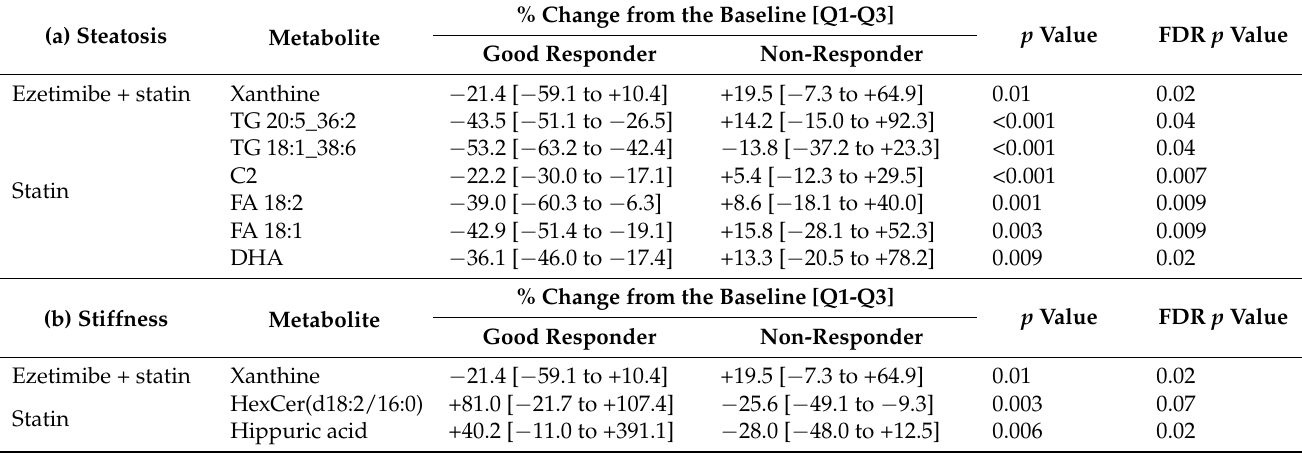
Table 2. Significantly different changes in metabolite levels between the good and non-response groups after receiving the two treatments (ezetimibe + statin and statin alone). ( a ) Significant metabolites associated with the improvement in MRI-PDFF values. ( b ) Significant metabolites associated with the improvement of MR elastography value. Metabolite changes were defined as the change in concentration compared with the baseline values. A p value < 0.05 was considered significant, and the FDR p value <